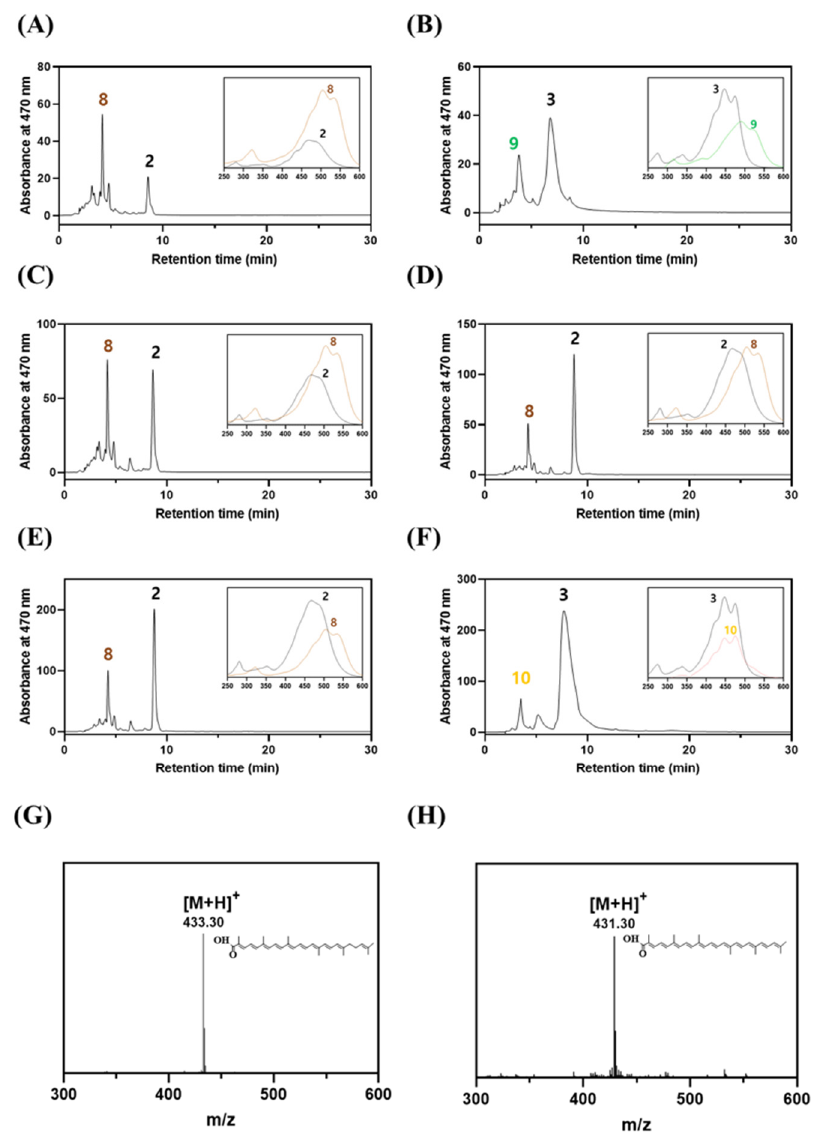
Figure 3. Functional analysis of four putative AldH enzymes in heterologous E. coli and LC-MS analysis. HPLC analysis of cell extracts of recombinant E. coli expressing ( A ) crtM SA -crtN SA -crtP SA (as a negative control), ( B ) crtM SA -crtN SA -crtP SA + aldH SA of S. aureus (as a positive control), ( C ) crtM SA -crtN SA -crtP SA + aldH420 PF , ( D ) crtM SA -crtN SA -crtP SA + aldH905 PF , ( E ) crtM SA -crtN SA -crtP SA + aldH1759 PF , and ( F ) crtM SA -crtN SA -crtP SA + aldH2454 PF . The insert UV / VIS spectra in the panels correspond to peaks in the HPLC chromatogram. The peak numbers (2,3,8,9 and 10) refer to the corresponding structures in Figure 1B. LC-MS analysis of ( G ) 4,4 (cid:48) -diaponeurosporenoic acid (3; M + H] + = 433.30) and ( H ) 4,4 (cid:48) -diapolycopenoic acid (10; [M + H] + = 431.30).